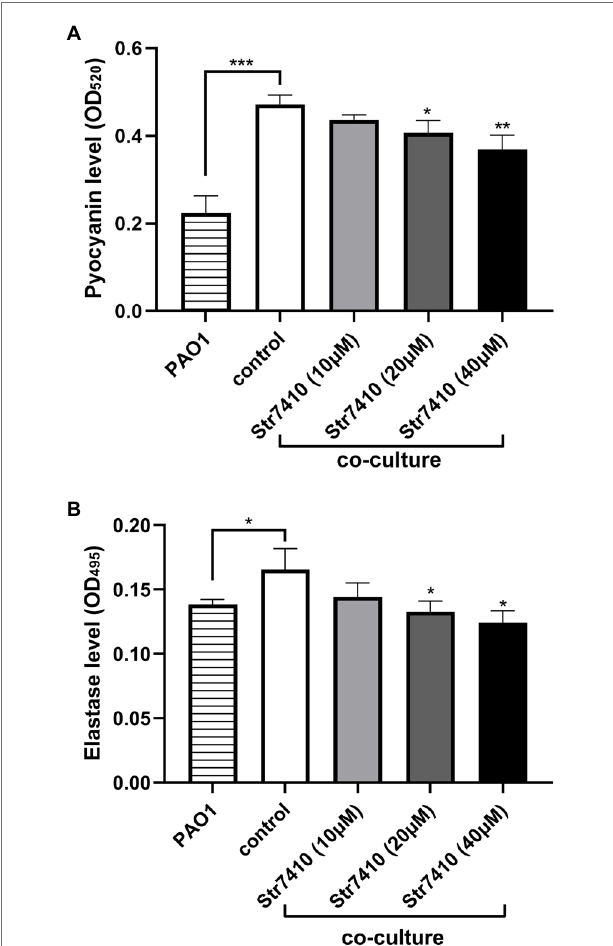
FIGURE 5 | Production of virulence factors by Pseudomonas aeruginosa PAO1 in monoculture or co-culture with Staphylococcus aureus ATCC 25923, and the inhibitory effect of compound Str7410 on virulence factor production in co-culture. (A) Pyocyanin; (B) Elastase. Values are presented as mean ± SD ( n = 3). Differences in data were compared with the untreated control at each time-point and considered significant when p < 0.05 (* p < 0.05, ** p < 0.01, and *** p < 0.001) by one-way ANOVA with t